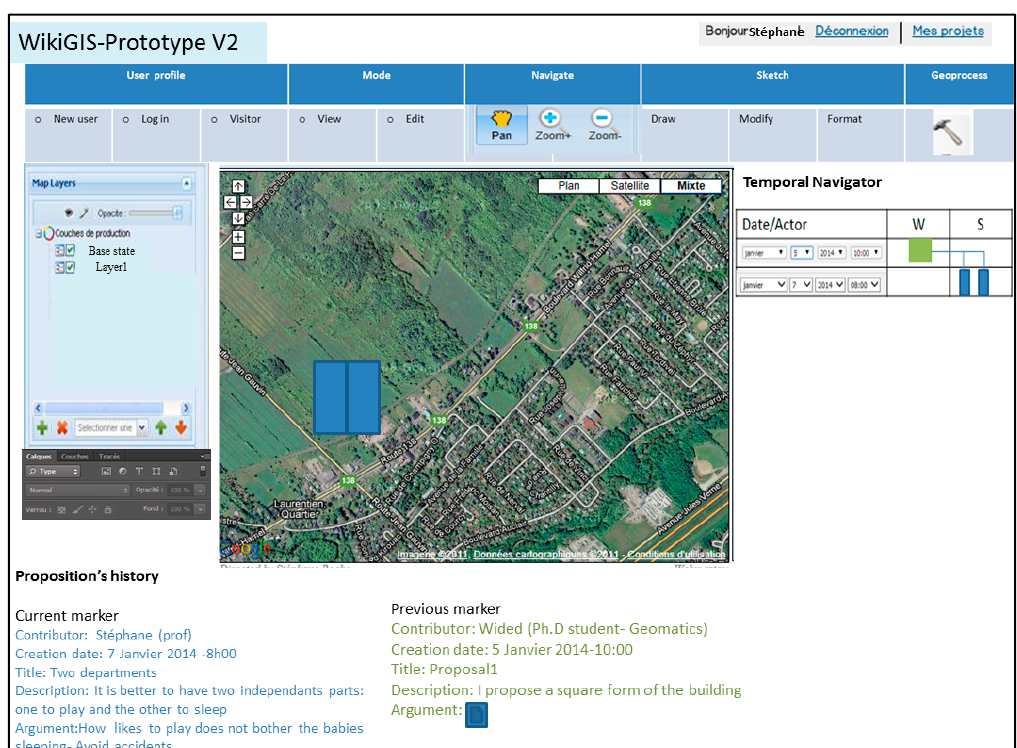
Figure 23. Second proposal in the project.